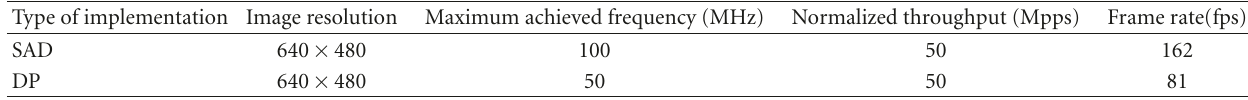
Table 1: Processing speeds for the SAD and DP accelerators.